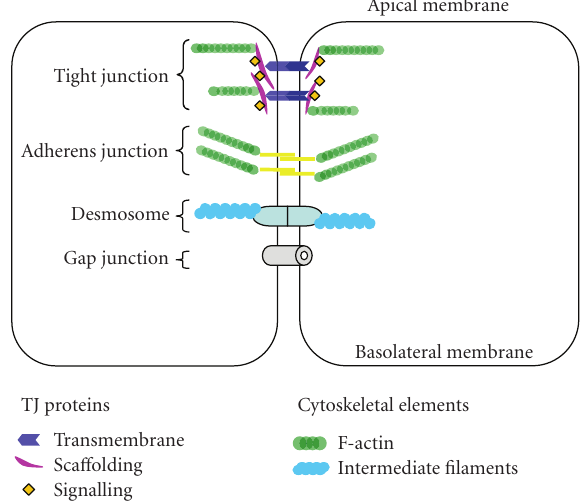
Figure 1: Epithelial cell-cell adhesion